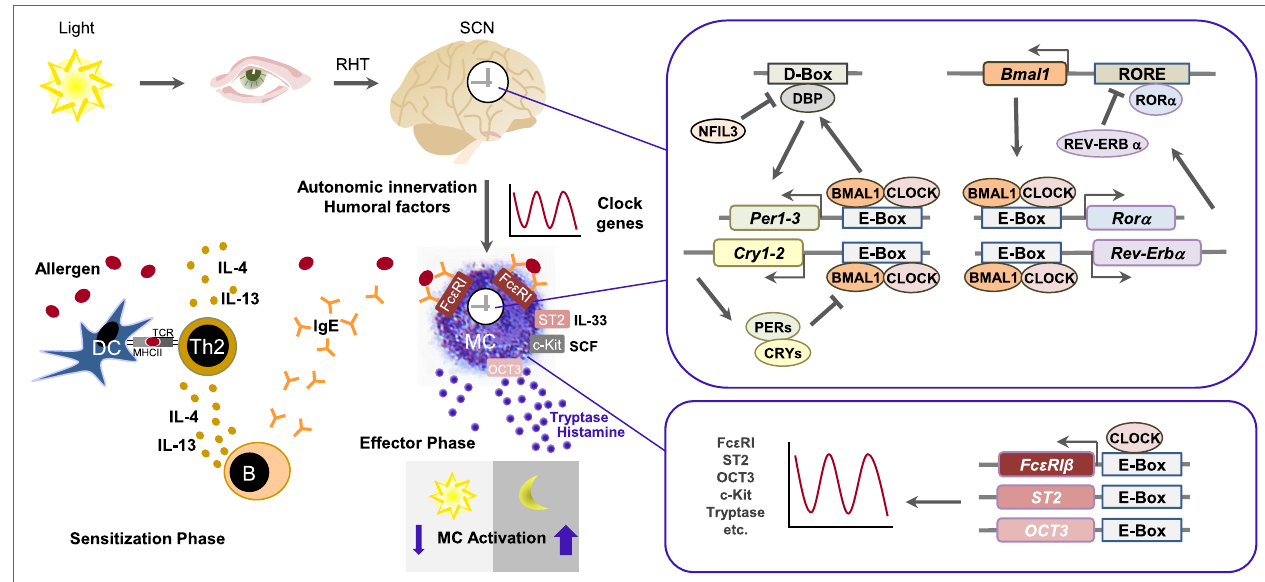
FigURe 1 | The mast cell clock in type I allergic reaction. Allergens are taken up by antigen-presenting cells such as dendritic cells (DC), which present them to naïve CD4 + T cells via major histocompatibility complex class II. In the presence of IL-4, naïve CD4 + T cells differentiate into Th2 cells. Secretion of IL-4 or IL-13 by Th2 cells causes an isotype switch to IgE in B cells. Allergen-specific IgE engages to Fc ε RI on mast cells. If allergens bind to specific IgE, Fc ε RI is cross-linked, followed by the release of mast cell mediators such as histamine and tryptase and induction of allergic symptoms. The circadian clock consists of the central oscillator, located in the suprachiasmatic nucleus (SCN) of the hypothalamus, and peripheral oscillators present in virtually all cell types. Light activates photoreceptors and via retinohypothalamic tract (RHT) the central SCN clock. Peripheral circadian clocks are synchronized and entrained by autonomic innervation and humoral factors. Clocks in peripheral tissues use the same molecular components like present in SCN, as the core molecular clock consists of interlocked transcriptional and translational feedback loops. Core clock proteins BMAL1 and CLOCK form a heterodimer and, by binding to E-box-motifs, induce the expression of other clock components. Among them are BMAL1 positively regulatory proteins like ROR α as well as negatively regulatory proteins like REV-ERBs, PERs, and CRYs, thus concurrently attenuate their own transcription and initiate a new transcription cycle. DBP and NFIL3 form another loop that regulates transcription of genes containing D-box sequences, including those for PERs, and thus cooperate with the core clock to establish robust 24-h rhythms. The mast cell clock may temporally gate expression of Fc ε RI, ST2, OCT3, etc., via CLOCK and E-box elements, thereby generating a marked circadian variation in IgE/mast cell-mediated allergic